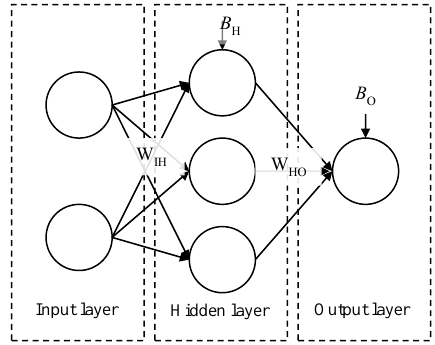
Figure 2. An example of a three-layer multilayer perceptron feed- forward ANN, with two input neurons, the hidden-layer neurons, and one output neuron. WIH are the weights between the input and hidden layers, WHO are the weights between the hidden and output layers, BH are the biases in the hidden layer, and BO is the bias in the output